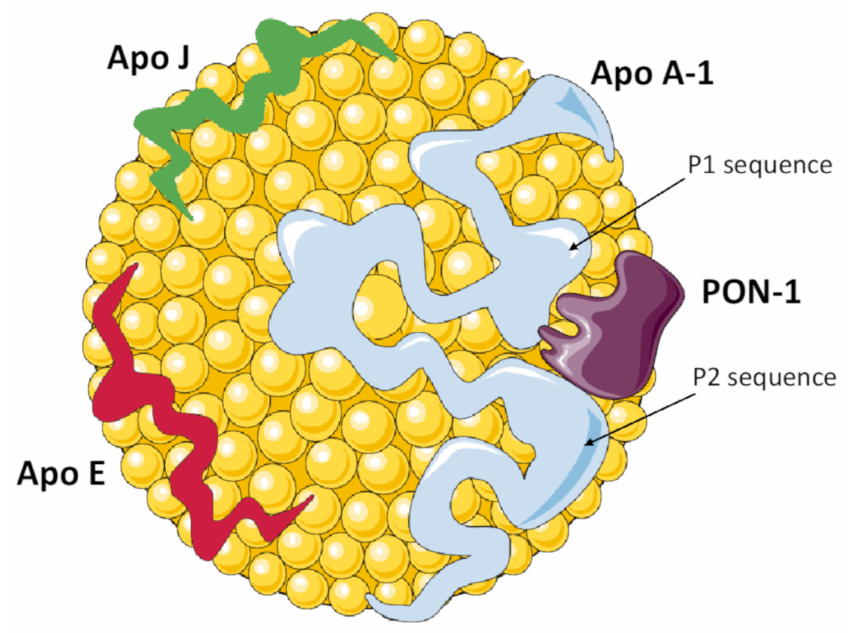
Figure 1. High-density lipoprotein (HDL) particle and its main proteome. ApoA-1 is the major protein constituent of HDL, playing a crucial structural and functional role. PON1 is present in a small fraction of HDLs, and its antioxidant activity strictly depends on its binding to apoA-1, through the interaction domains P1 and P2. Apo E is one of the major components of lipoprotein particles in plasma, including HDL, as well as of the HDL-like particles in the central nervous system (CNS). Apo J is expressed in di ff erent tissues and is present in biological fluids; in the CNS it is bound to HDL-like particles and seems to be involved in A β